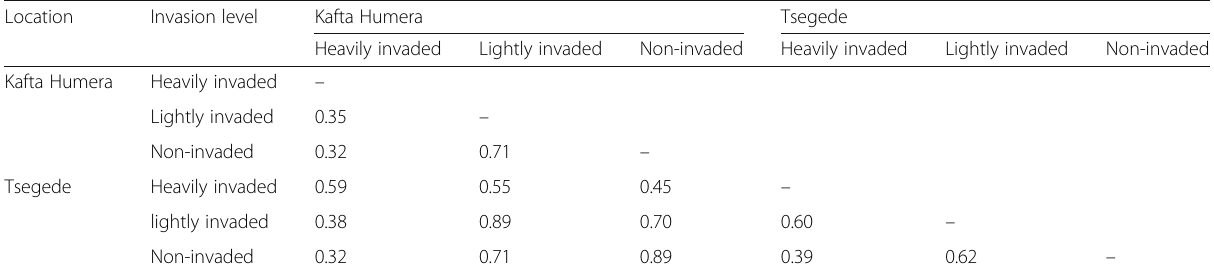
Table 4 Jaccard coefficient of similarity for herbaceous species under three Senna obtusifolia invasion levels (non-invaded; lightly invaded, and heavily invaded) at two locations in northern Ethiopia Location Invasion level Kafta Humera Tsegede Heavily invaded Lightly invaded Non-invaded Heavily invaded Lightly